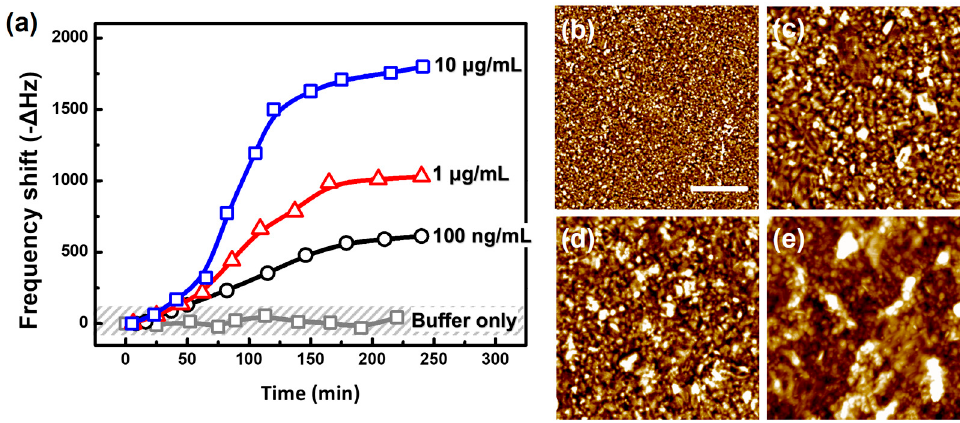
Figure 5. The resonant responses and topographic analysis of A β aggregation on sensor surfaces ( a ) Monitoring time-dependent responses of A β aggregation on the seed-immobilized cantilever surface with newly added A β 42 peptide with concentrations of 100 ng/mL, 1 µg/mL, and 10 µg/mL; Topographic images of ( b ) the seed-immobilized Au surface and A β aggregation with concentration of ( c ) 100 ng/mL; ( d ) 1 µg/mL; and ( e ) 10 µg/mL. (A scale bar is 250 nm).